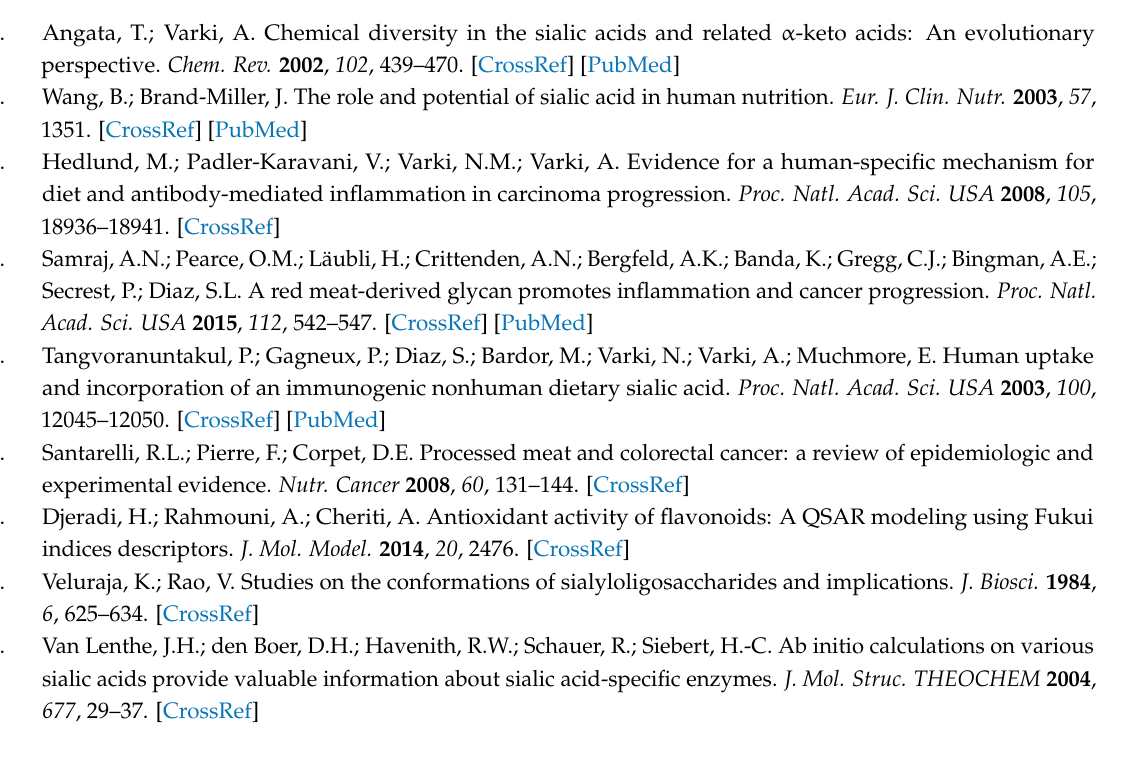
Table S1: Molecules bond length and angle parameters of Neu5Gc and Neu5Ac, Table S2: Natural bond orbital of Neu5Gc and